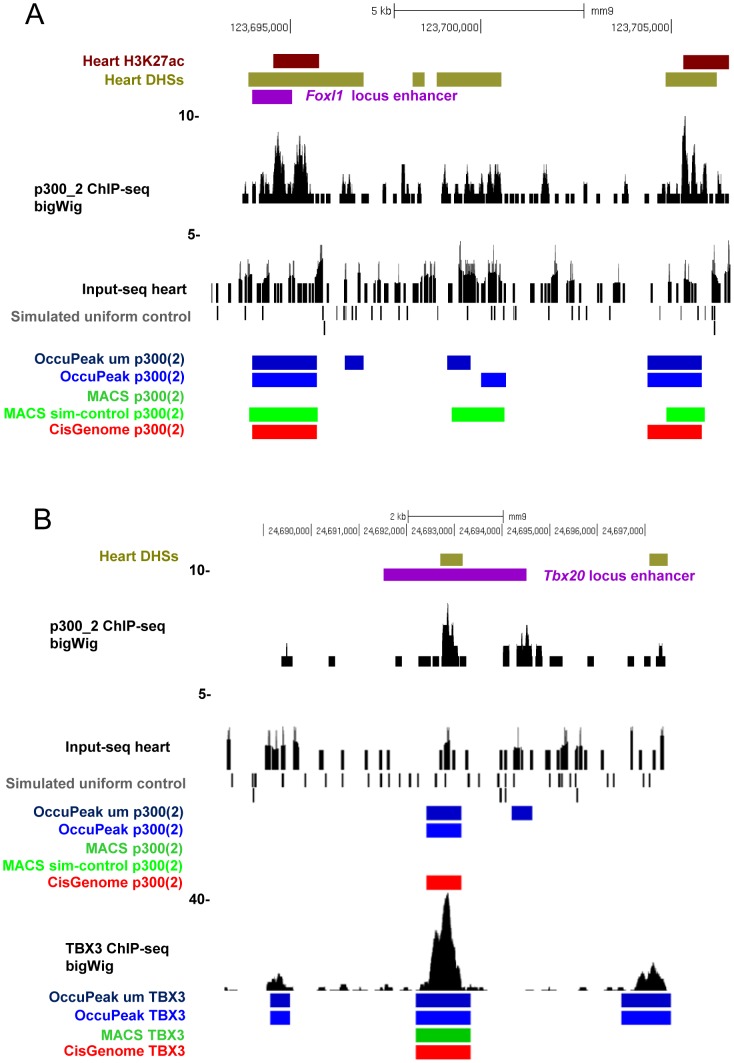
Visualization of overlap analysis.Visual inspection with the UCSC genome browser can show where and why certain enhancers are missed by a particular peak-calling method. A. Relatively small local increases in input control tag density can result in a locally decreased sensitivity of the method. An enhancer on the Foxl1 locus is missed by MACS when heart Input-seq data is used as input control, but detected when a simulated uniform dataset is used as control instead. B. Similarly, an enhancer located on the Tbx20 locus is missed by MACS when an input control is used on the p300(2) data. When applying the same input control on the more abundant TBX3 data, the enhancer is marked by all methods. Abbreviations: um  =  dataset in which only unique tags are mapped; sim-control  =  dataset where simulated uniform data is used as input control for peak-calling.